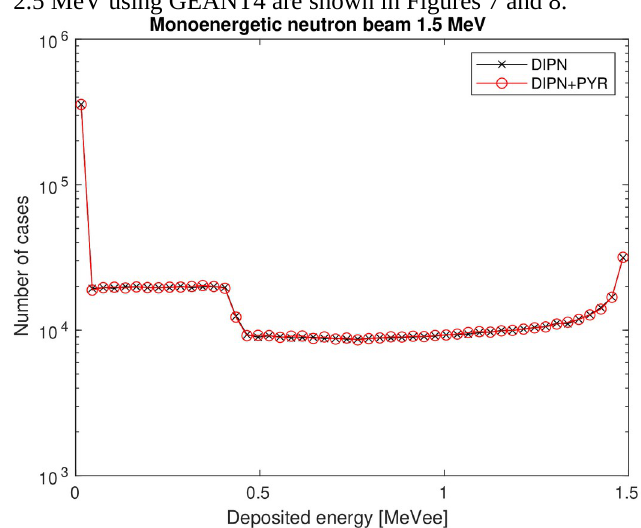
Fig 7: Deposited energy of scintillator with only DIPN and DIPN with luminophore to neutrons of energy 2.5 MeV.